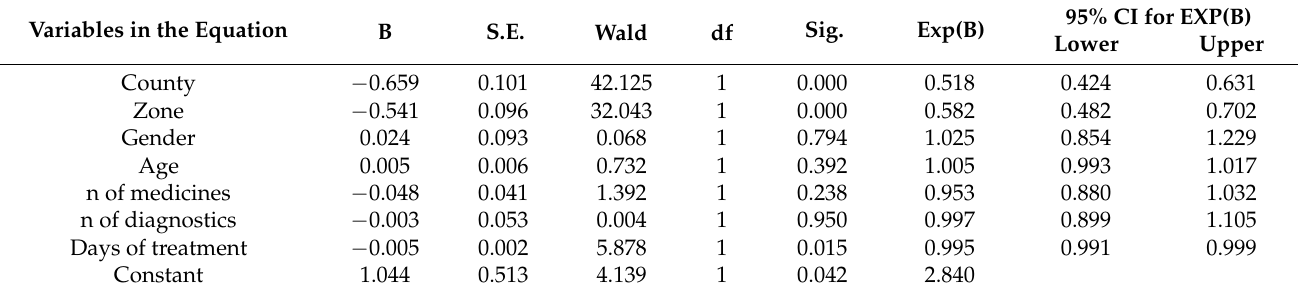
Table 6. Logistic regression considering PIM (Yes/No) as a dependent